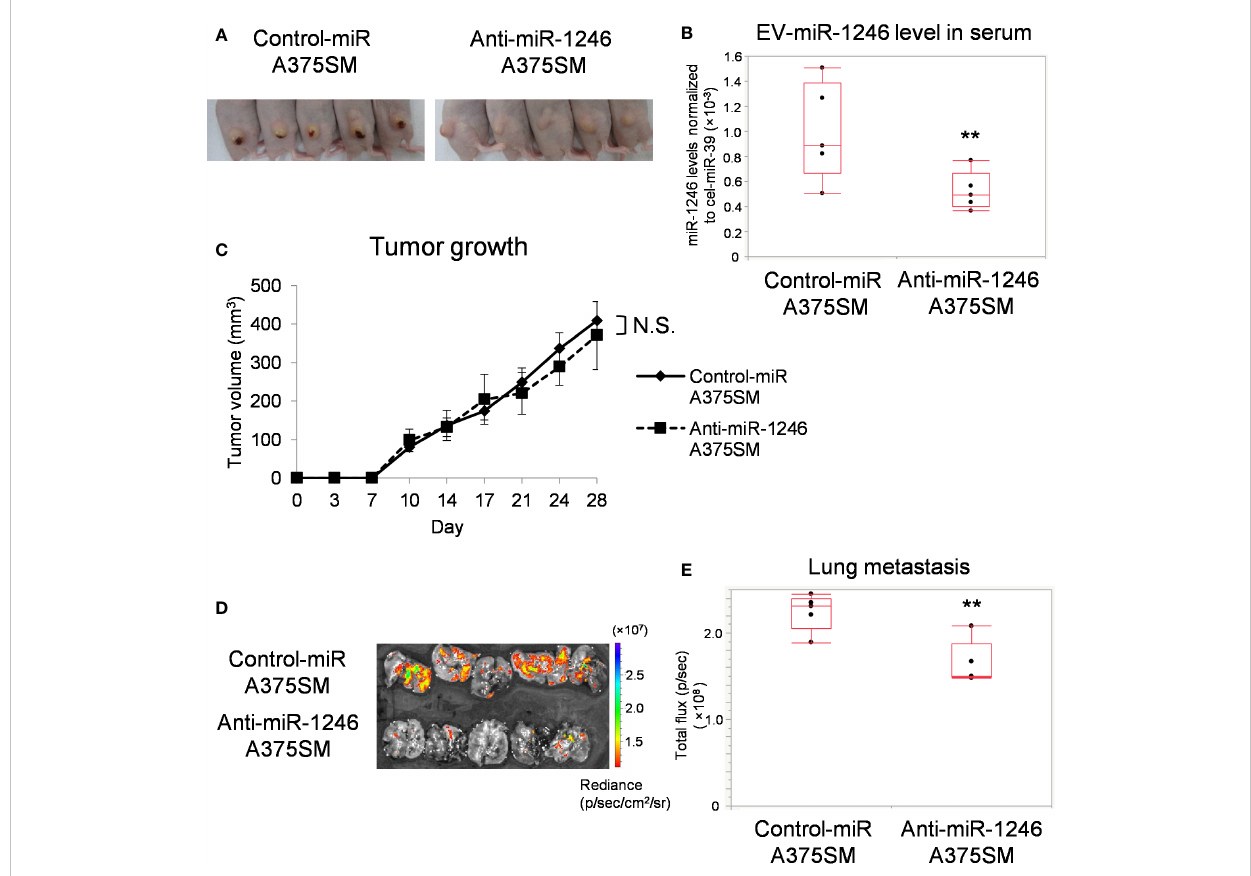
FIGURE 2 miR-1246 knockdown of tumor cells reduces lung metastasis. (A) Images of mice, 28 days after subcutaneous injection of Control-miR A375SM and Anti-miR-1246 A375SM. (B) miR-1246 levels in serum EVs from Control-miR A375SM or Anti-miR-1246 A375SM tumor-bearing mice. Sera were collected 28 days after subcutaneous injection of each tumor (**P = 0.037, Wilcoxon test; data are presented as mean ± SD; n = 3 real-time RT- PCR runs, n = 5 mice per group). (C) Tumor volume was assessed using the formula: (width 2 × length)/2 (mm 3 ). Two-sided Student ’ s t-test. N.S.: not signi fi cant. P = 0.42 (D) Tumor cell fl uorescence intensity (GFP signal) in the lungs was detected using IVIS Spectrum. Quantitative analysis of fl uorescence intensity (Total fl ux) was shown in (E) (**P = 0.022, Wilcoxon test; n = 5 mice per